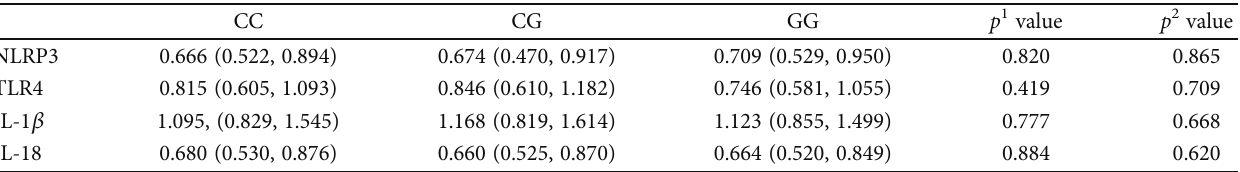
p 1 values represent the di ff erence between genotypes (Kruskal-Wallis test). p 2 values represent the di ff erence between homozygous wild type (CC) and the G-allele (CG and GG combined) (Mann – Whitney test).